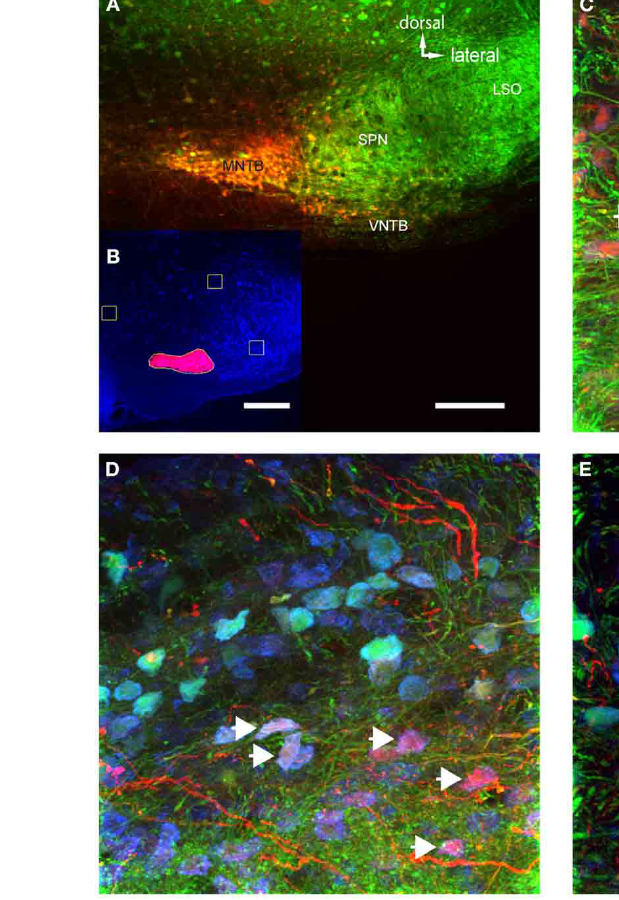
VNTB from a brain where the tracer injection into the ipsilateral MNTB was moderate (5.5% of MNTB volume). (E) Represents a section of VNTB from a brain where the tracer injection into the ipsilateral MNTB was minimal (1.5% of MNTB volume). (A,C–E) are maximum projections of confocal stacks (image depth: 80 µ m), (B) is based on an epifluorescence microscopy image taken at low magnification (10 × ). Scale bar for (A) : 200 µ m, for (B) : 500 µ m and (C–E) : 50 µ